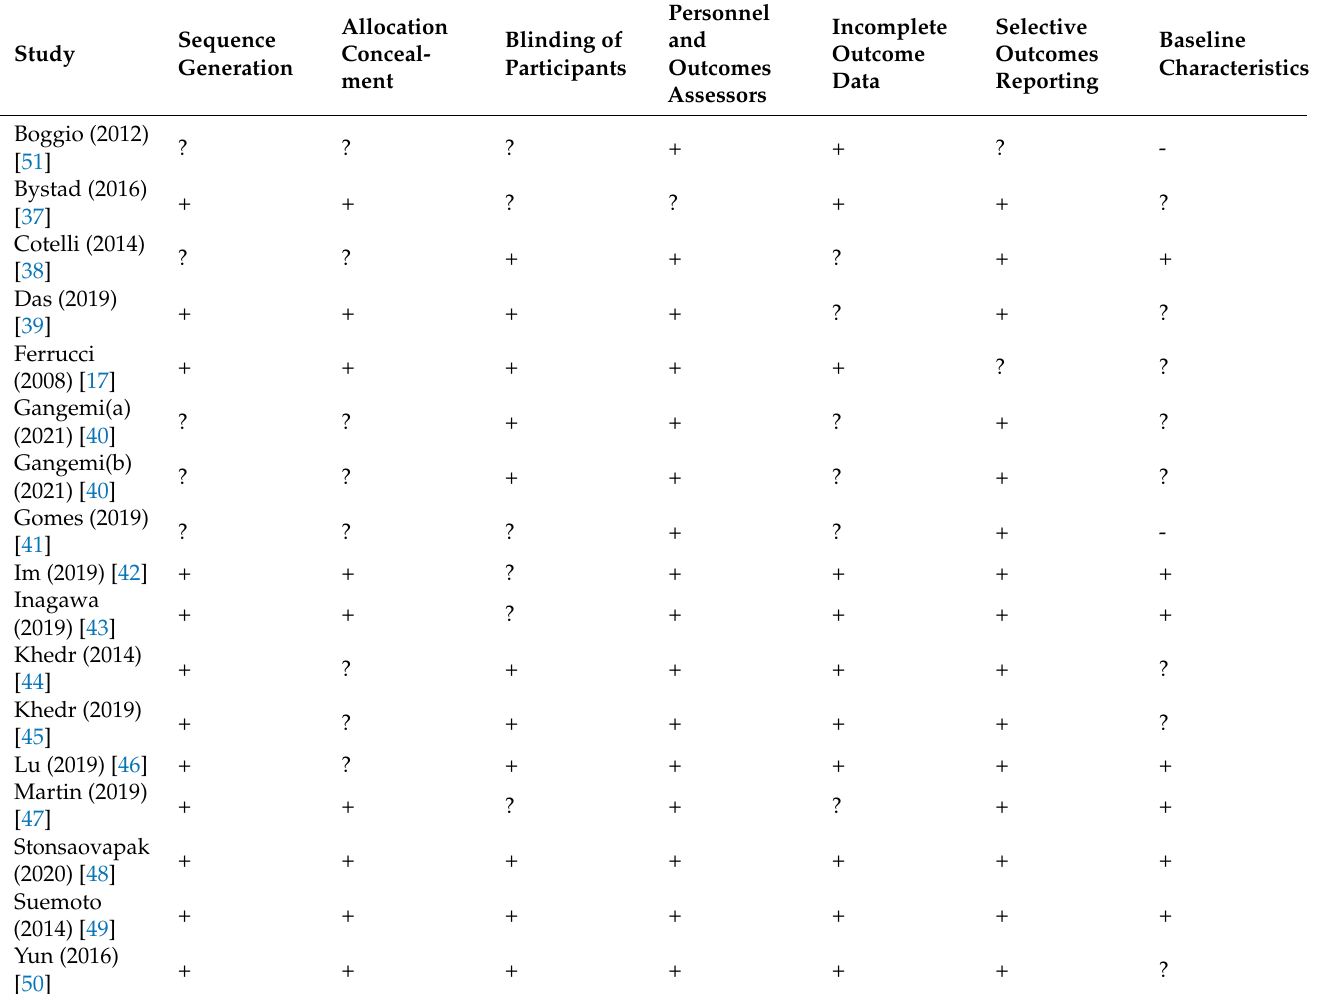
Table 3. Assessment of risk of bias for included